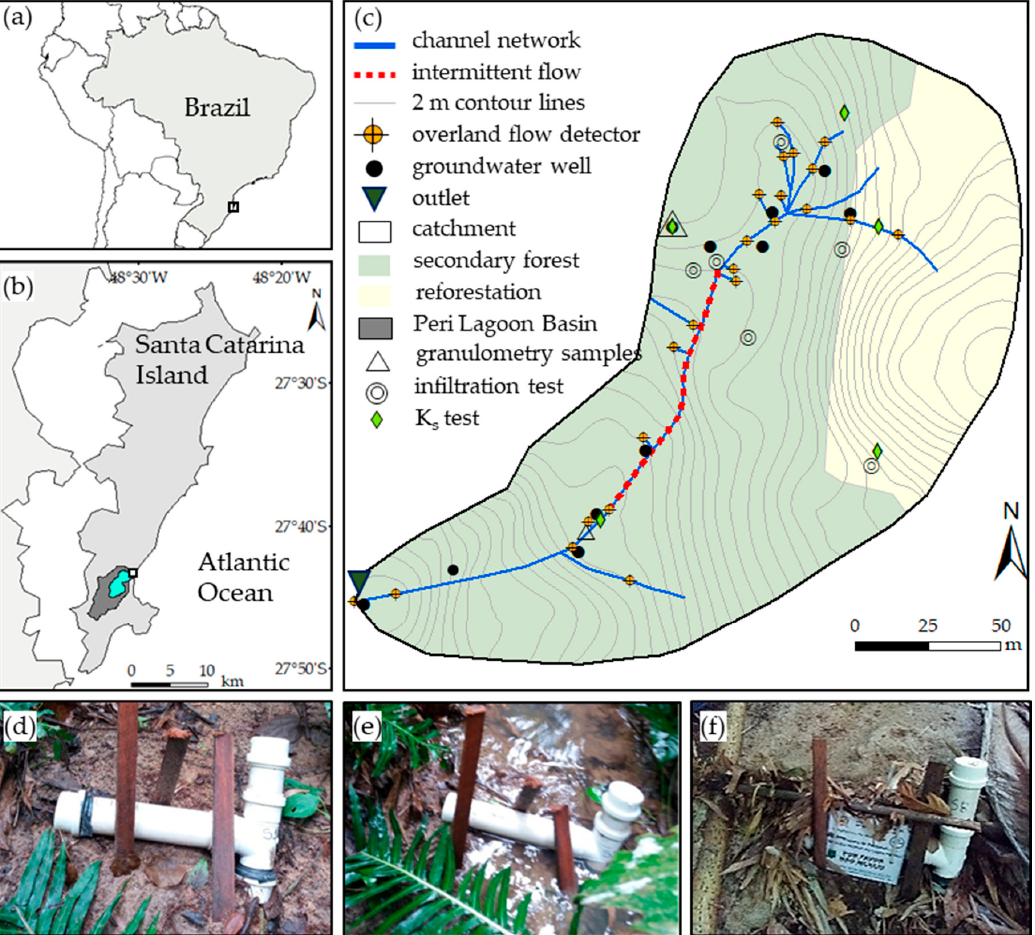
Figure 1. The Peri Lagoon watershed is located in Southern Brazil ( a , b ). ( c ) Retiro headwater catchment, with the channel system, position of intermittent flow, locations of overland-flow detectors, location of the soil samples, infiltration and saturated hydraulic conductivity (K s ) tests, groundwater wells, outlet site, and forest cover. ( d ) View of overland-flow detector installed within the ephemeral channel before the rainfall event, and ( e ) during a rainfall event. ( f ) Litter fall and sediments transported by storm runoff.